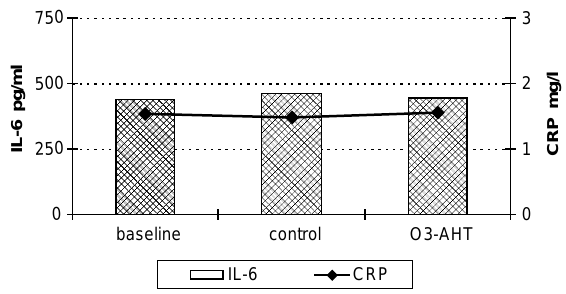
FIG. 1. CRP and IL-6 plasma concentrations after control autohemotherapy and after ozonated autohemotherapy